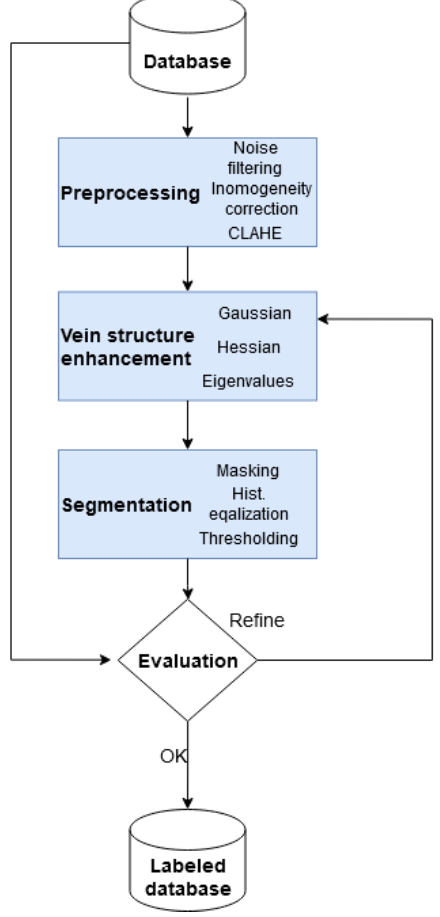
Figure 1. Automated